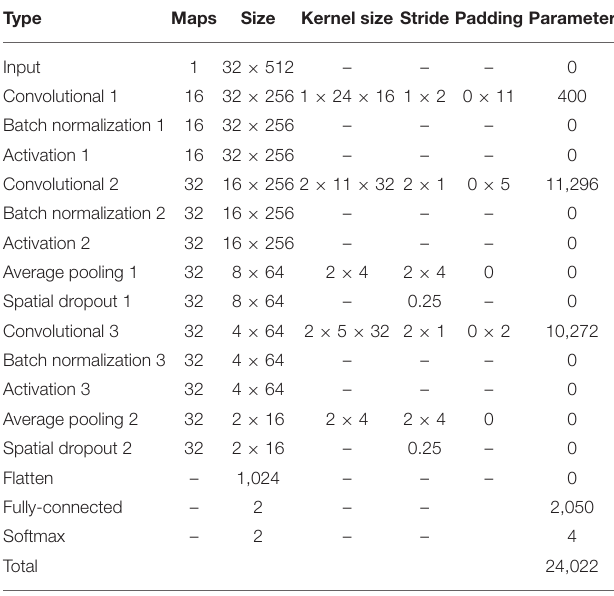
TABLE 1 | Implementation details for proposed CNN